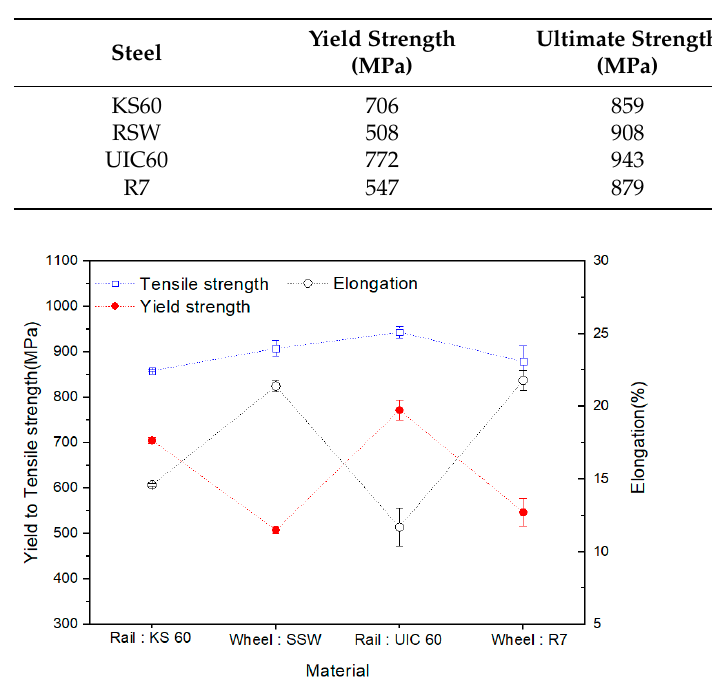
Figure 4. Comparison of yield and tensile strength by wheel and rail steel.